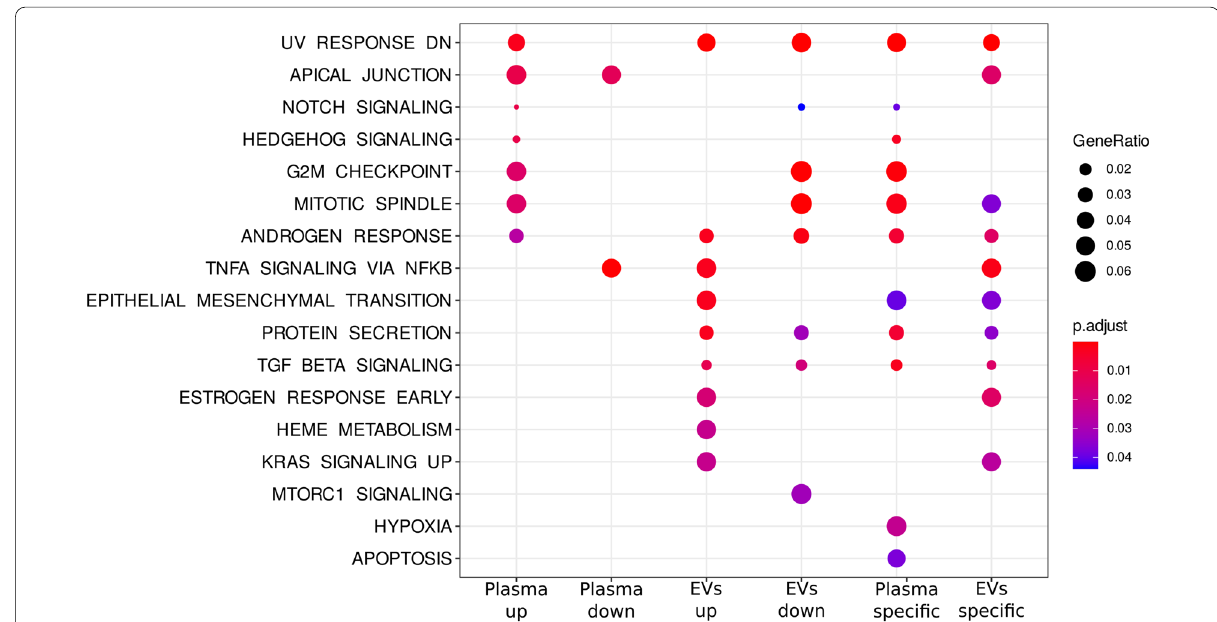
Fig. 4 Results of the ‘hallmark’ enrichment analysis among targets of differentially expressed miRNAs in plasma, extracellular vesicles, and between the two compartments (plasma up—analysis for miRNA up‑regulated in plasma, plasma down—analysis for miRNA down‑regulated in plasma, EVs up—analysis for miRNA up‑regulated in EVs, EVs down—analysis for miRNA down‑regulated in EVs, plasma specific—analysis for miRNA which abundance in plasma is higher than in EVs, in comparison to controls, EVs specific—analysis for miRNA which abundance in EVs is higher than in plasma, in comparison to controls)